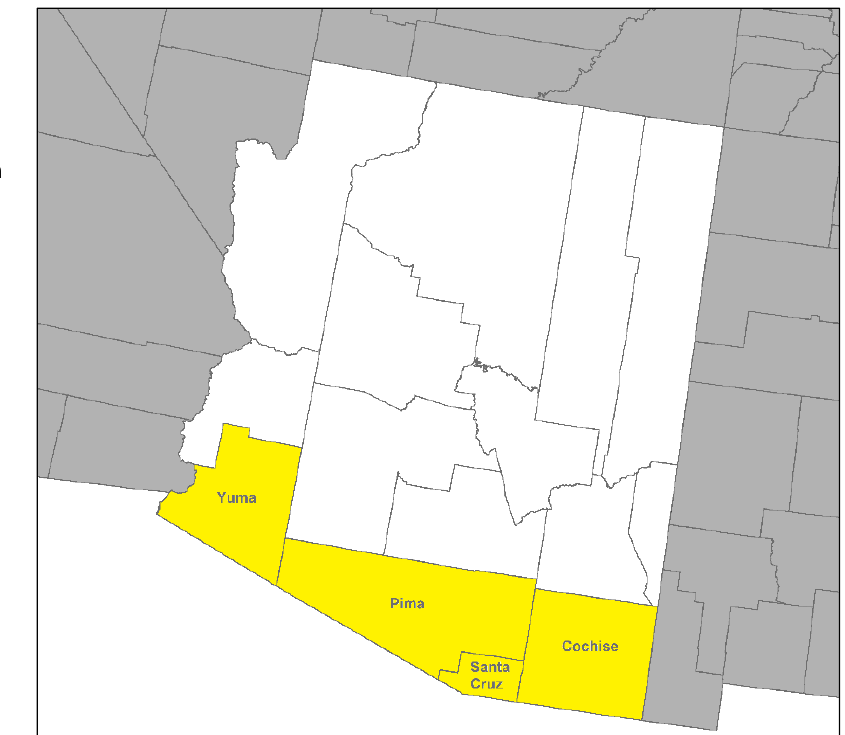
Figure 2. Pima, Cochise, Santa Cruz, and Yuma Counties — Analysis